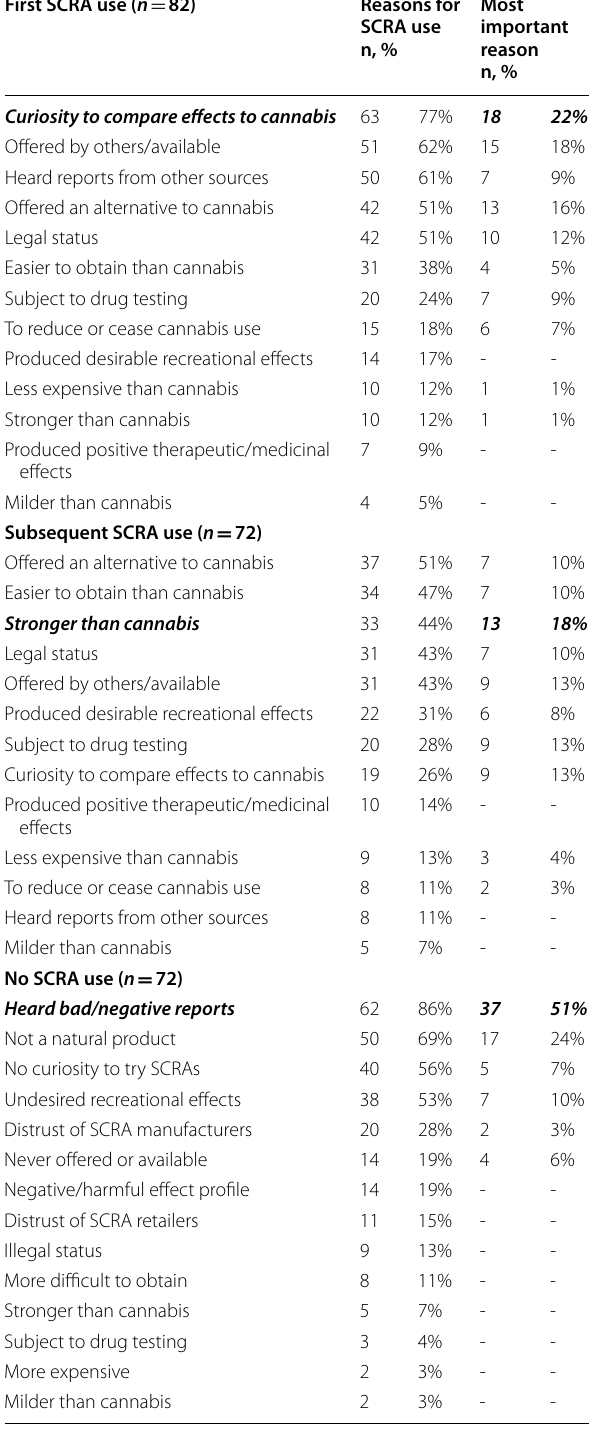
Table 5 Logistic regression model predicting SCRA use in an Australian cannabis treatment population ( N Characteristics